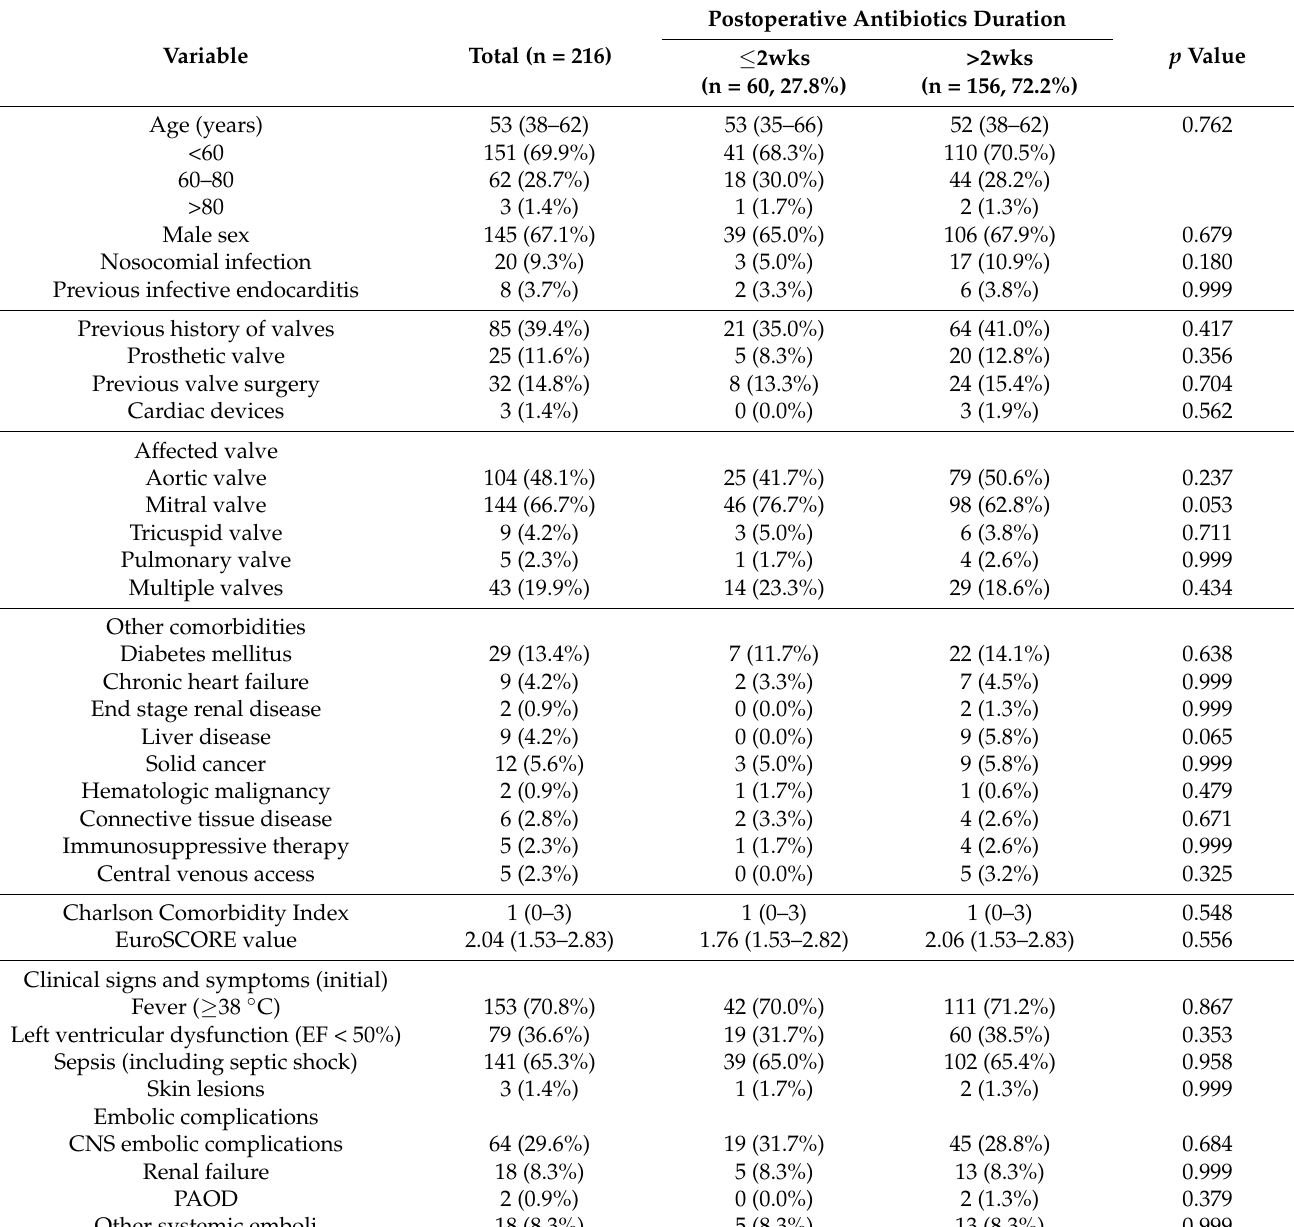
Table 1. Baseline characteristics of patients with infective endocarditis who underwent valve